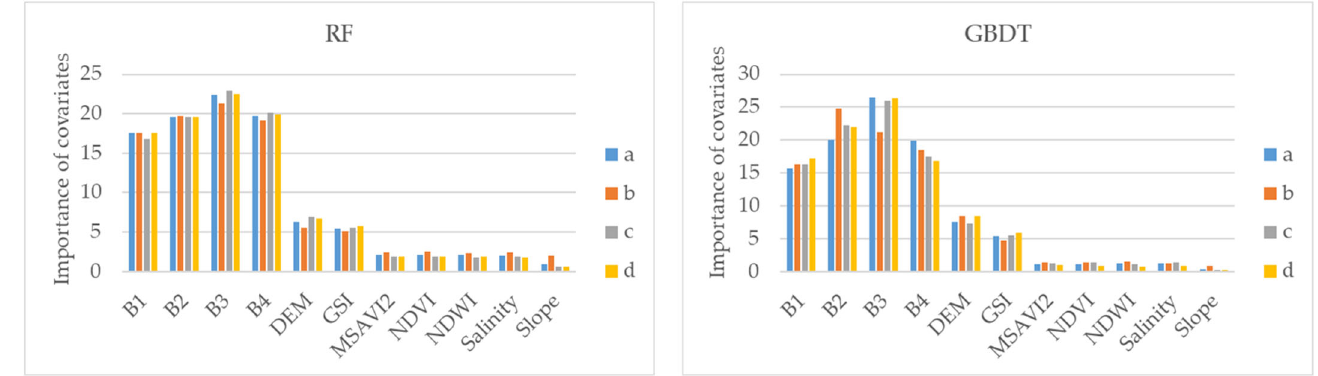
Figure 15. The mean value of covariates importance ranked by RF and GBDT. ( a ) Represents the mean statistic of the importance of covariates in all 380 repeated experiments with different sets of training samples. ( b ) Represents the mean statistic of the importance of covariates in 20 repeated experiments when the number of training samples is 90. ( c ) Represents the mean statistic of the importance of covariates in 20 repeated experiments when the number of training samples is 270. ( d ) Represents the mean statistic of the importance of covariates in 20 repeated experiments when the number of training samples is